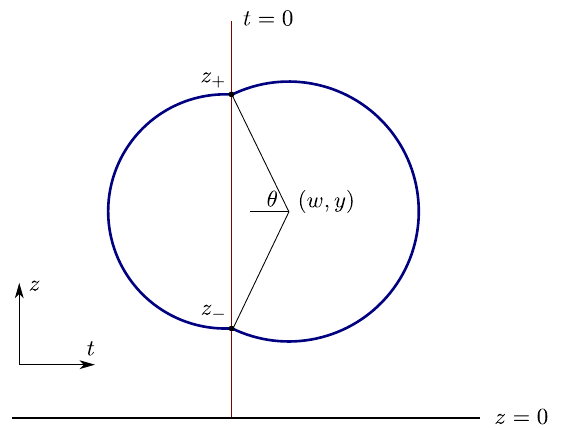
Figure 5 . Massive particle distorting the boundary of a near- AdS 2 space. Red line is the trajectory of the particle, blue line is two arcs of the NAdS 2 boundary, and solid black line is the boundary of the true AdS